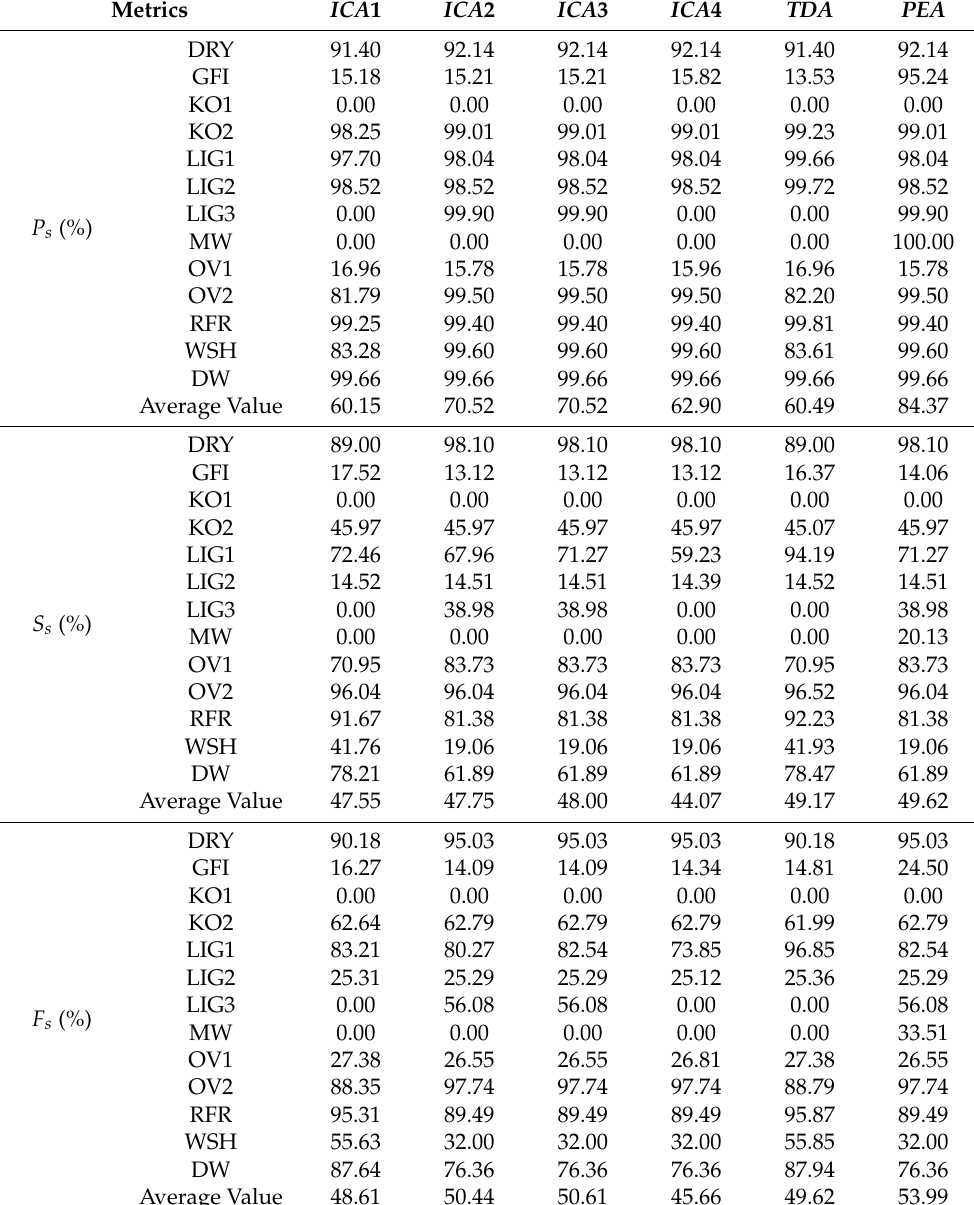
Table 9. Detailed results comparison of REDD-based NILM (Appliance